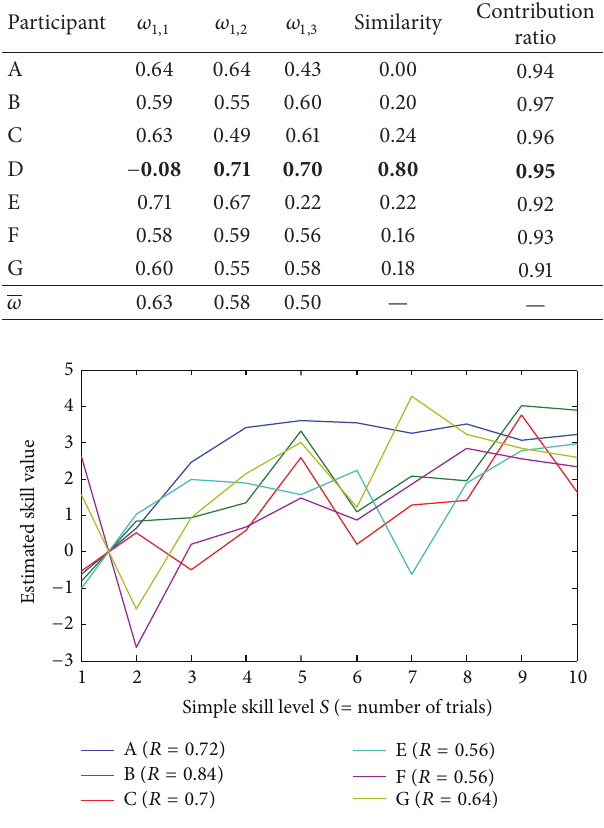
Figure 10: Transition of estimated skill level